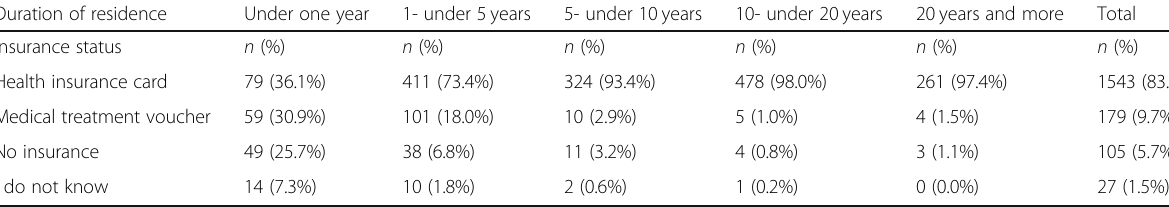
Table 3 Duration of residence in Germany and health insurance status ( n = 1854), p <